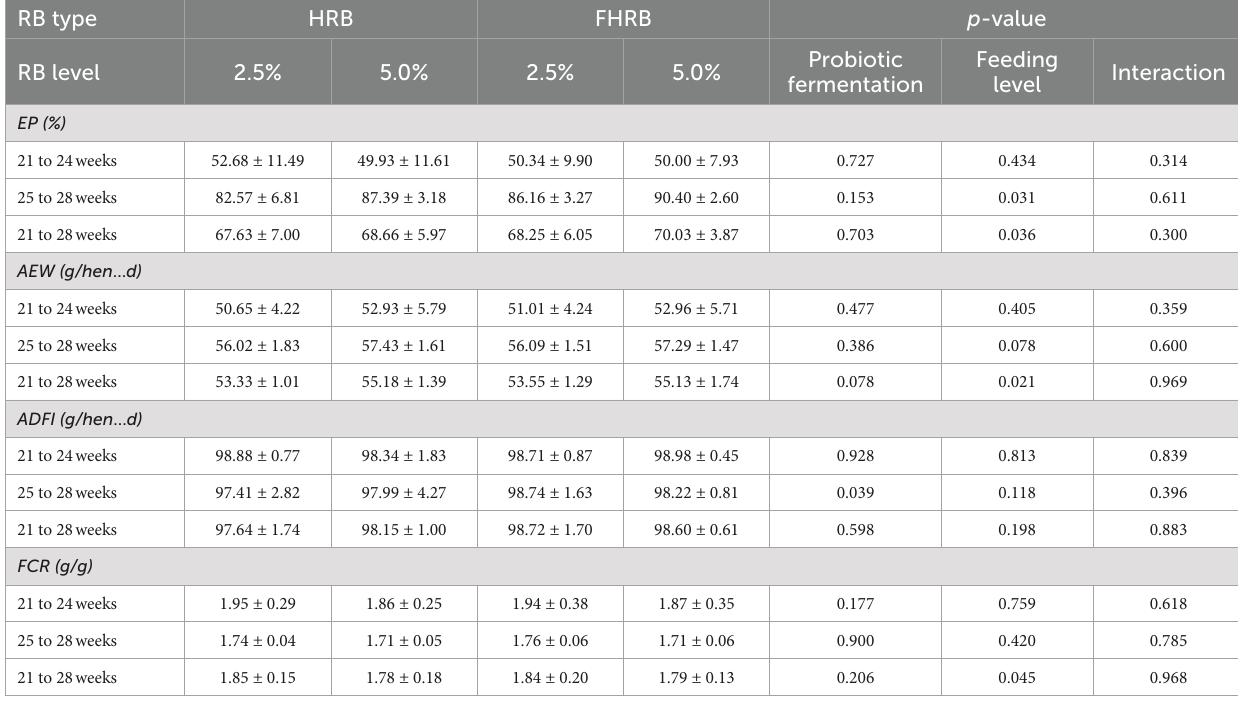
TABLE 2 Effects of RB type and feeding level on the production performance of laying hens. RB type HRB FHRB p -value